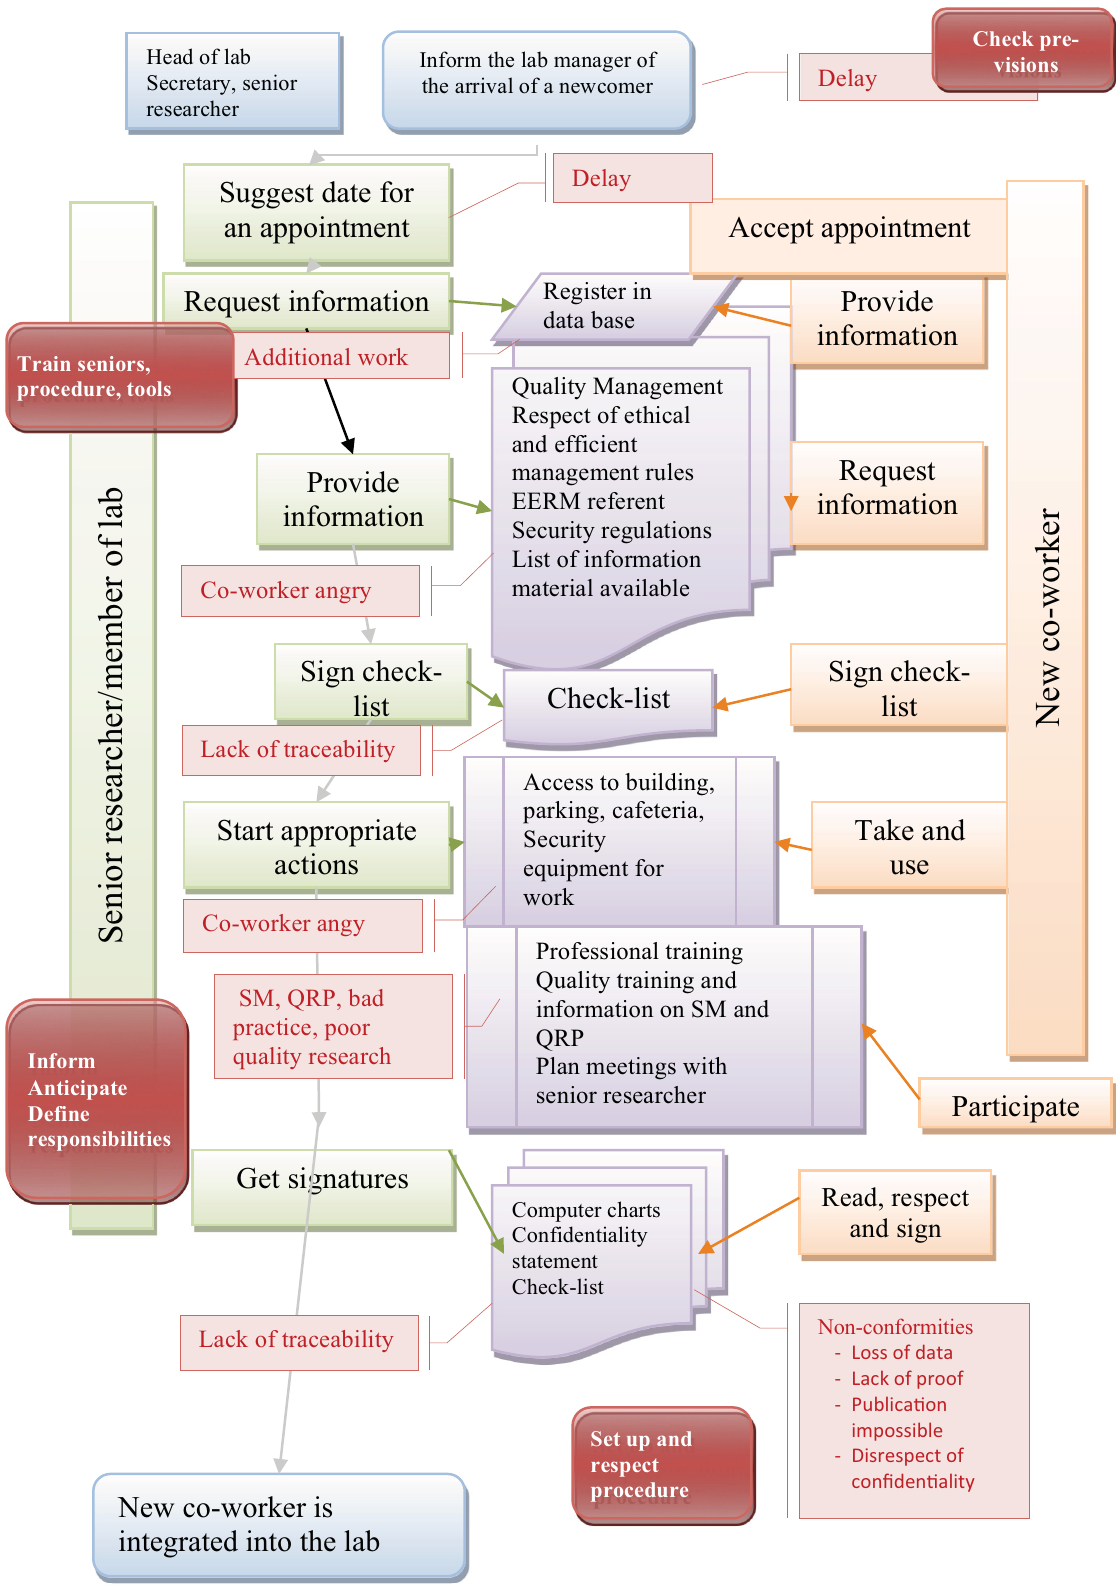
Fig. 4. Arrival of a co-worker: fl ow-chart including risky steps and management of the risk (dark